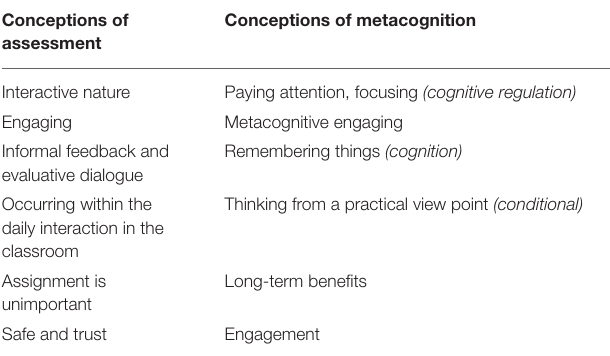
TABLE 8 | Jason’s conceptions of assessment and